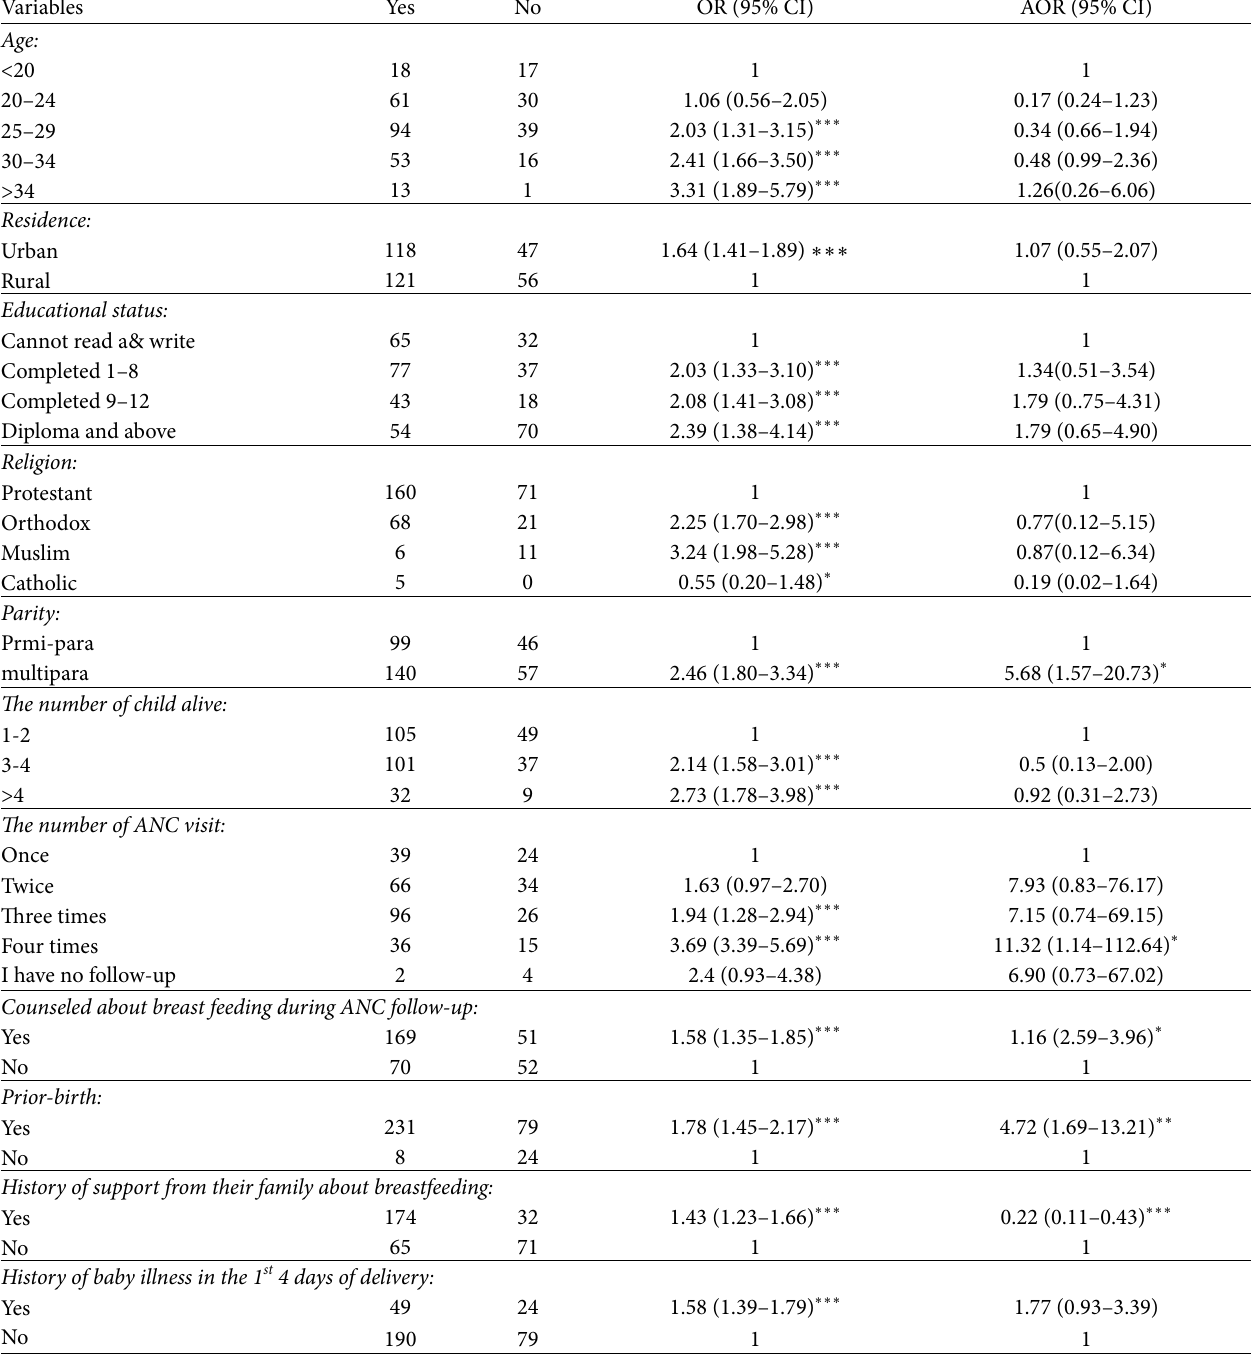
Table 6: Bivariate and multivariate logistic regression analysis of attitude colostrum feeding and its explanatory variables ( 𝑛 = 342 ).